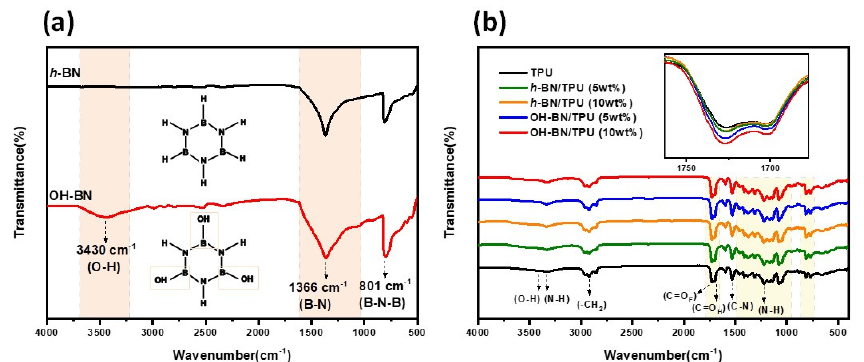
Figure 3. FT-IR spectra of ( a ) the h -BN and OH-BN particles; ( b ) pure TPU compared to the h -BN/TPU and OH-BN/TPU composites (at 5 and 10 wt.% filler concentrations).